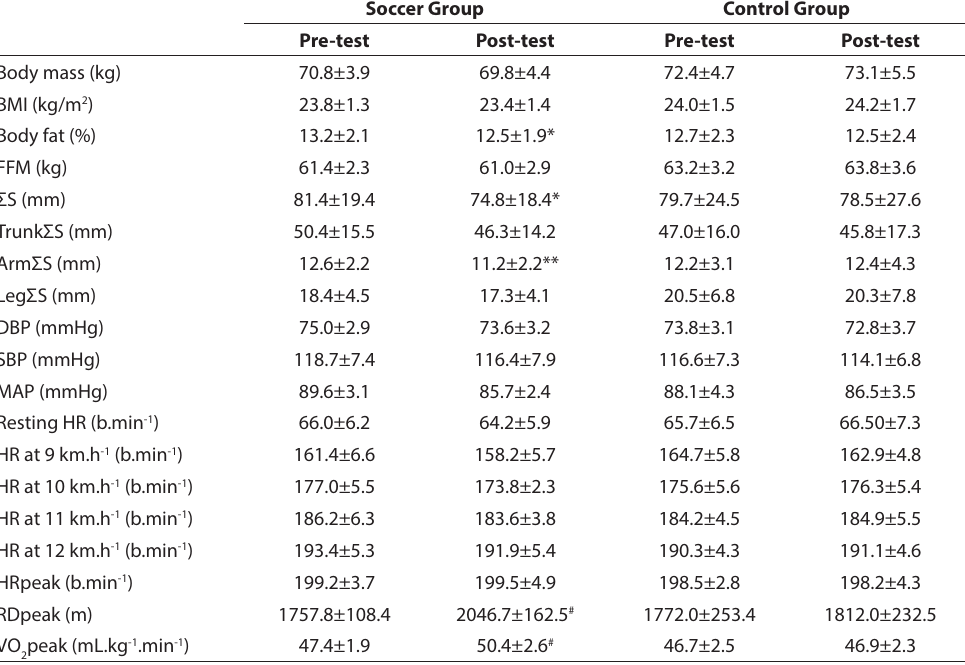
TABLE 1 Body composition, blood pressures, heart rate and aerobic endurance variables before and after the 8 weeks of weekly intervention in the soccer and control groups. Data are presented as means ± sd Soccer Group Control Group Pre-test Post-test Pre-test